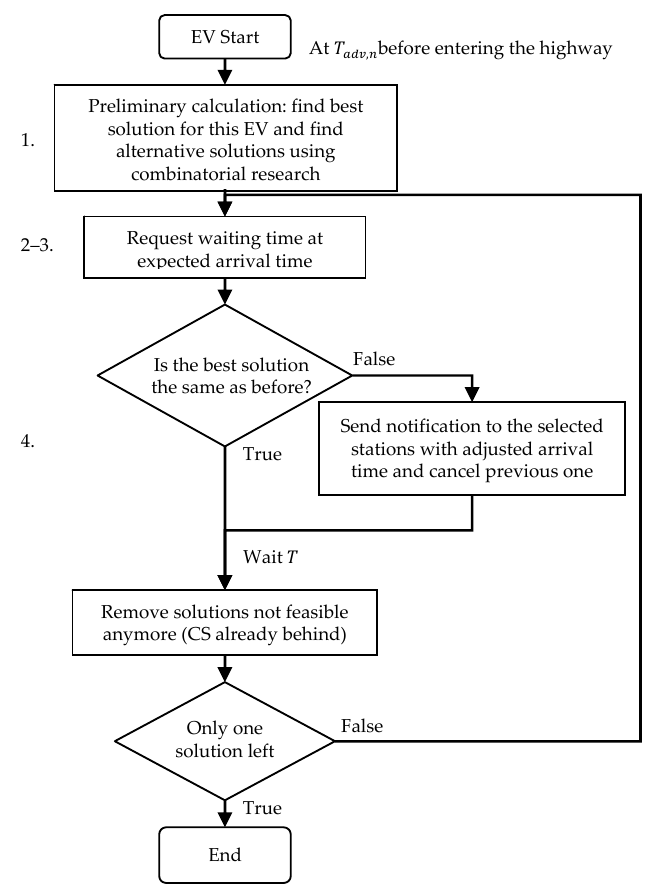
Figure 6. Communication flow chart from the vehicle point of view.